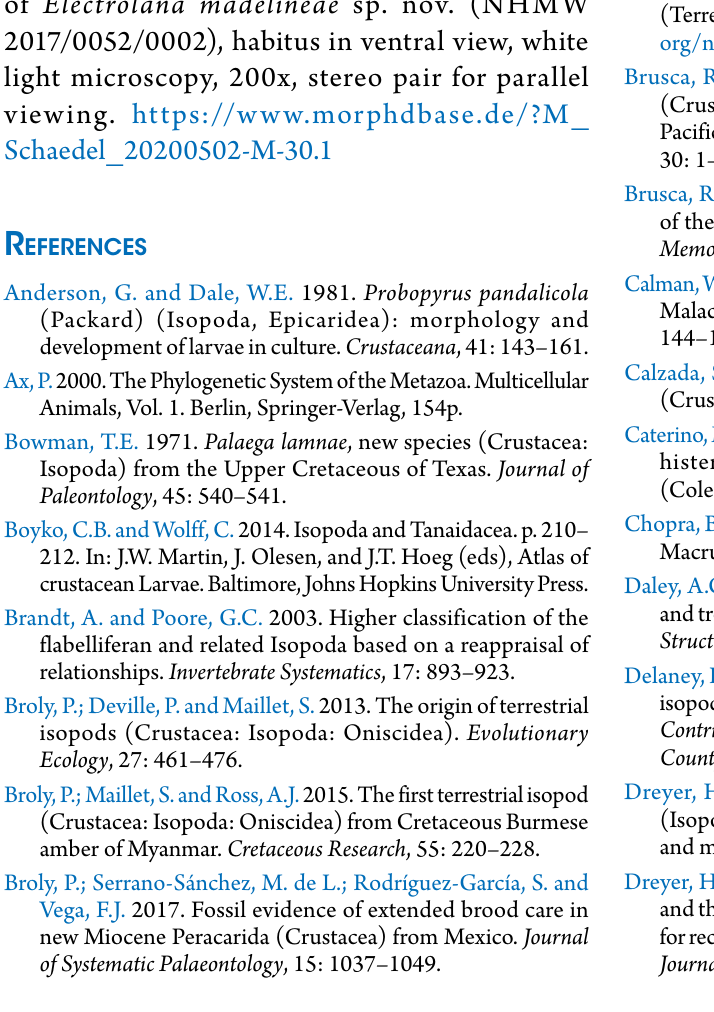
Supplementary file 10: Figure S8. Paratype of Electrolana madelineae sp. nov.